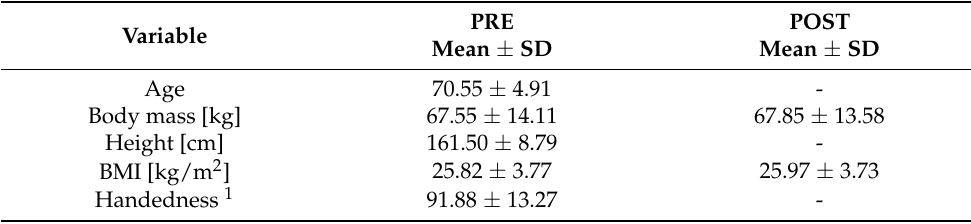
Table 1. Characteristics of